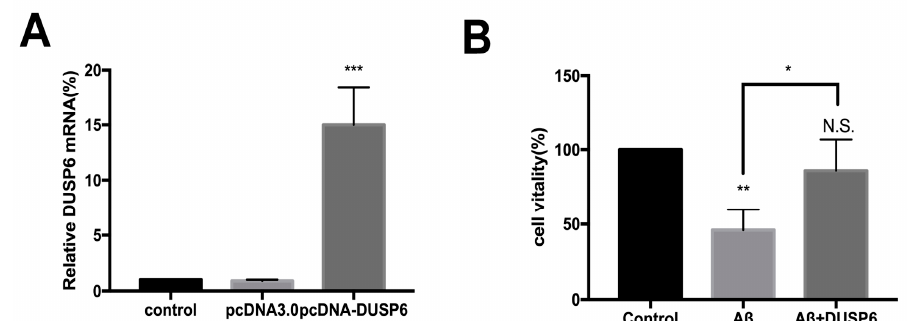
Figure 2. DUSP6 prevented the A β -triggered decrease in NSC viability. ( A ) DUSP6 mRNA was overexpressed after it was transfected with DUSP6-overexpressed plasmid pcDNA-DUSP6. pcDNA3.0 empty vector transfection showed no effect on DUSP6 expression in NSCs; ( B ) NSCs were either pre-transfected with DUSP6 overexpression plasmid or not transfected. Both groups were treated with 5 μ M A β 25–35 for 24 h. Cell viability assessed by CCK8 assay showed no significant change in A β -treated NSC vitality after DUSP6 transfection. N.S.: p > 0.05, **: p < 0.01, ***: p < 0.001 vs. control. *: p < 0.05 vs. A β -treated group. n = 3. N.S.: Not significant.